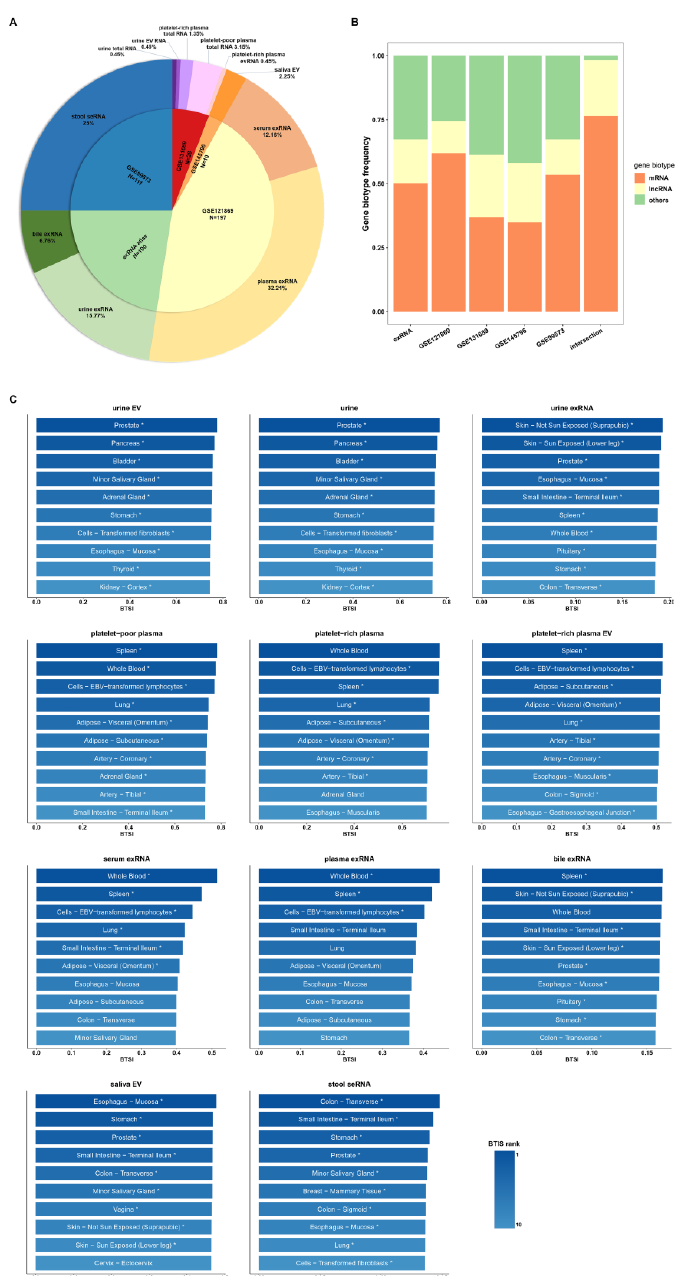
Figure 1. Overview of biofluid–tissue expression correlations. ( A ) Data source of collected biofluid genome profiles. The number of samples collected from each data source and the proportion of samples in the whole sample pool ( n = 444) are labeled in the inner and outer pies separately. ( B ) Frequency of mRNA and lncRNA in transcriptome profile collected from different data sources and final intersection matrix used for analysis. The color of the bars corresponds to different gene biotypes. ( C ) The bar plot shows the tissues of the top 10 highest BTSI value for each biofluid type from whole transcriptome view. Only tissues significantly correlated with biofluid (Spearman’s correlation, p -value < 0.05) and presented higher correlation with biofluid samples than randomized GTEx samples ( n = 1000; t -test, 10 times repeat, p -value < 0.05) are labeled using ‘*’. The color of each bar represents the rank of the tissue BTSI value for the corresponding